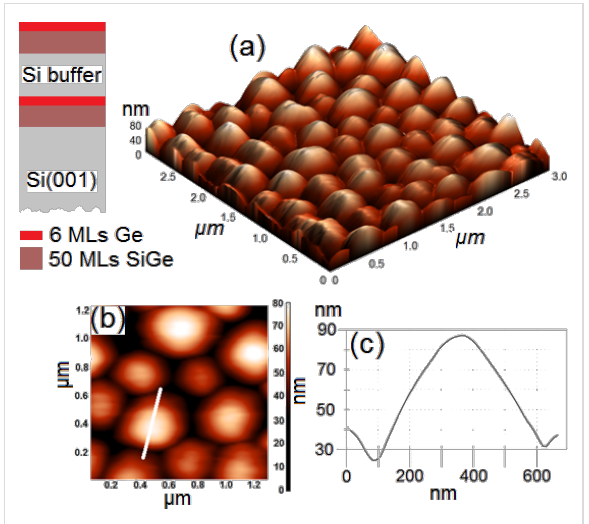
Figure 2: Sketch of the sample structure and AFM measurements performed on the sample surface after MBE growth: (a) 3 × 3 µm 2 3D image, b) 2D image, and c) height variations measured along the white line in (b).